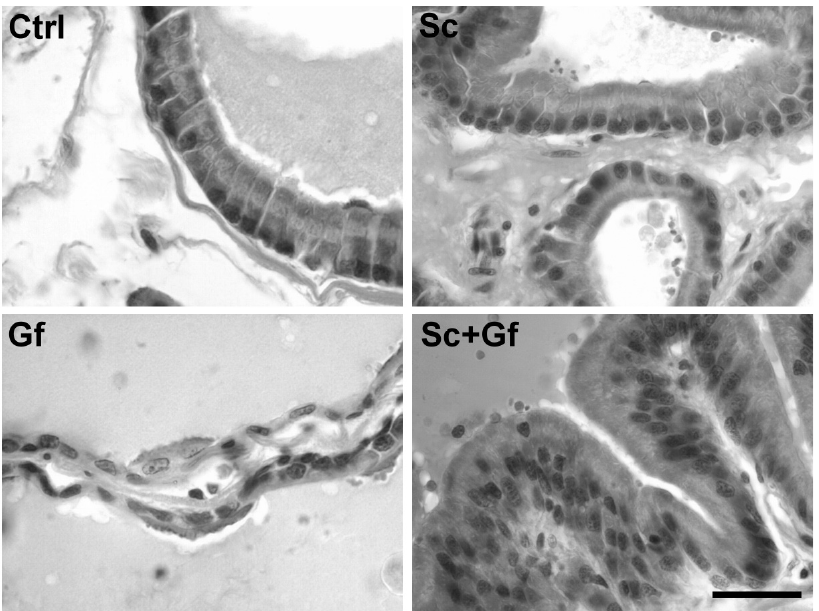
Fig. 2 – Prostate histology. Histological changes obtained after denervation of scrotal (Sc) and genitofemoral (Gf) nerves alone or in combination (Sc+Gf). Notice the clear alteration of the epithelium after denervation. Bar = 200 μ m.